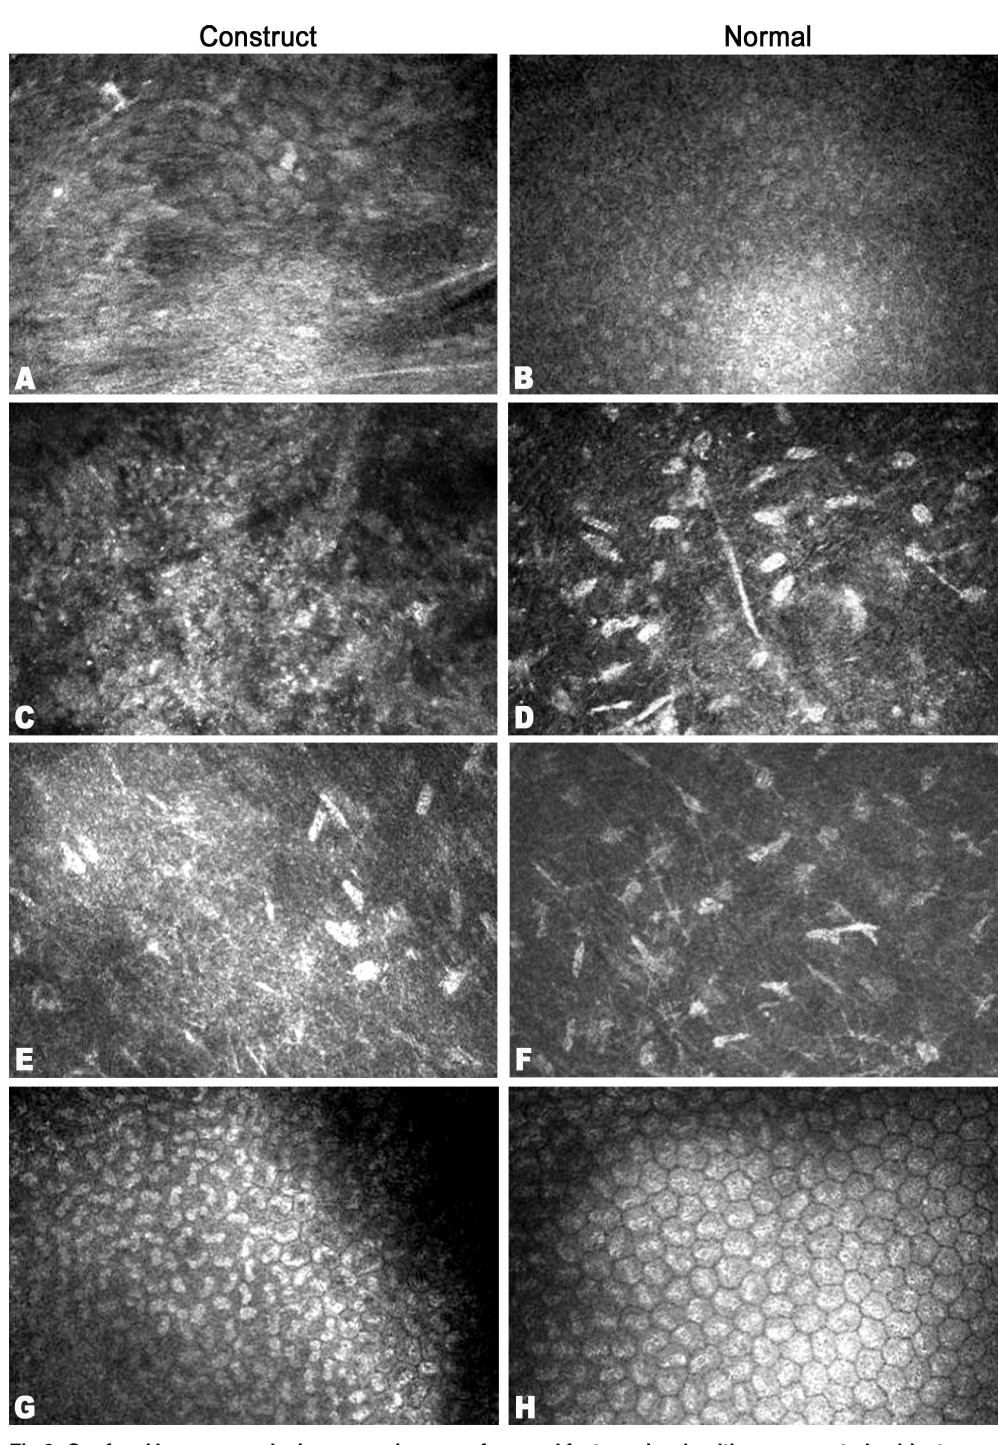
Fig 6. Confocal laser corneal microscopy images of corneal featuresin a healthy, unoperated subject, alongside those of operated corneas, at 6 months after construct implantation. Regeneratedcorneal epithelialcells on the implantsurface (A), and intact epitheliumof the normal cornea (B). Anterior stromal cell nuclei (C, D) and posterior stromal cells (E, F) were present, with no Langerhans cells or any other typical inflammatory cells immersed within. The endothelium(G, H) in all corneas exhibiteda characteristic mosaic